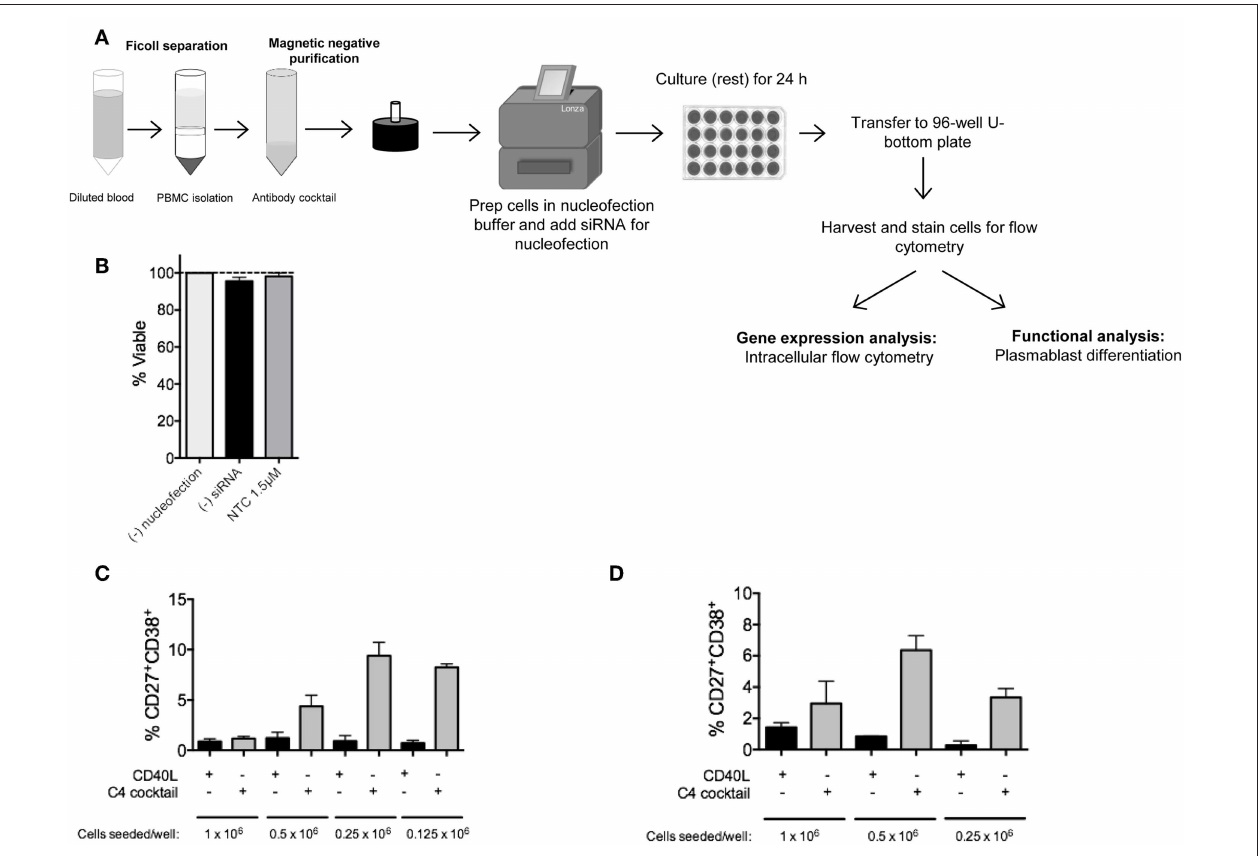
FIGURE 1 | RNAi knockdown in primary human naïve B cells by Amaxa nucleofection protocol. (A) Overview of nucleofection protocol and experimental readouts. (B) Isolated human naïve B cells were nucleofected with or without non-targeting control (NTC) siRNA and rested for 24h. Viability of cells after resting was determined by trypan blue staining ( n = 4). (C) Optimal seeding density of non-nucleofected primary human naïve B cells to generate plasmablasts in a 96-well plate via 7 day in vitro culture with C4 cocktail ( n = 4). (D) Same as (C) except optimal seeding density is shown for nucleofected cells ( n =